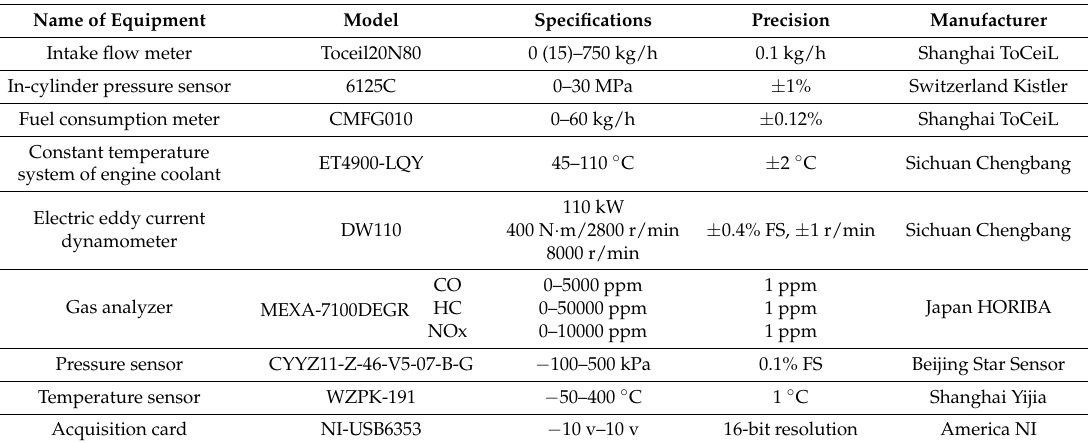
Table 3. Specifications and precision of measuring